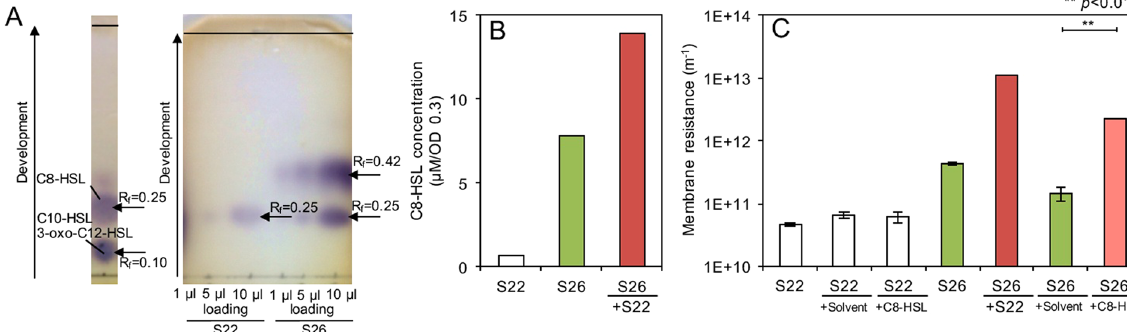
Figure 4. ( A ) Thin-layer chromatograph assay of N -acyl-homoserine-lactone (AHL) produced by S22 and S26 (Full-size images were shown in Fig. S2). ( B ) N -octanoyl-L-homoserine lactone (C8-HSL) concentration produced by single-culture of S22, S26, and co-culture of S22 and S26. ( C ) Effect of C8-HSL addition on the fouling potential of S22 and S26 culture. The error bars indicate the standard deviations of two independent experiments. The bar following sign indicates statistical difference between two groups with respective p value: ** P <